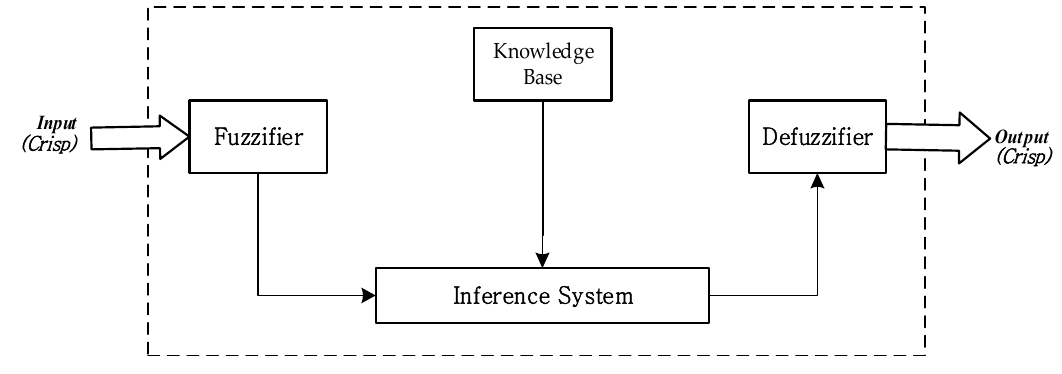
Figure 4. Structure of fuzzy controllers.